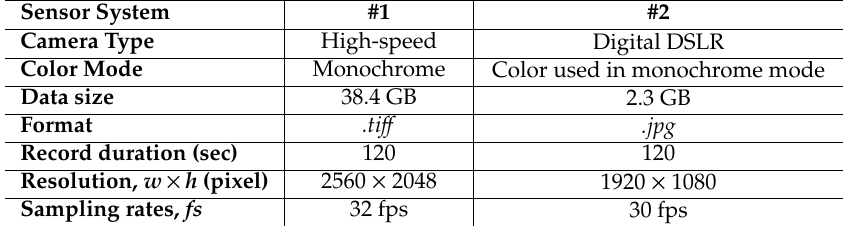
Table 8. Vision-based systems configuration for the seismic shake table test monitoring.